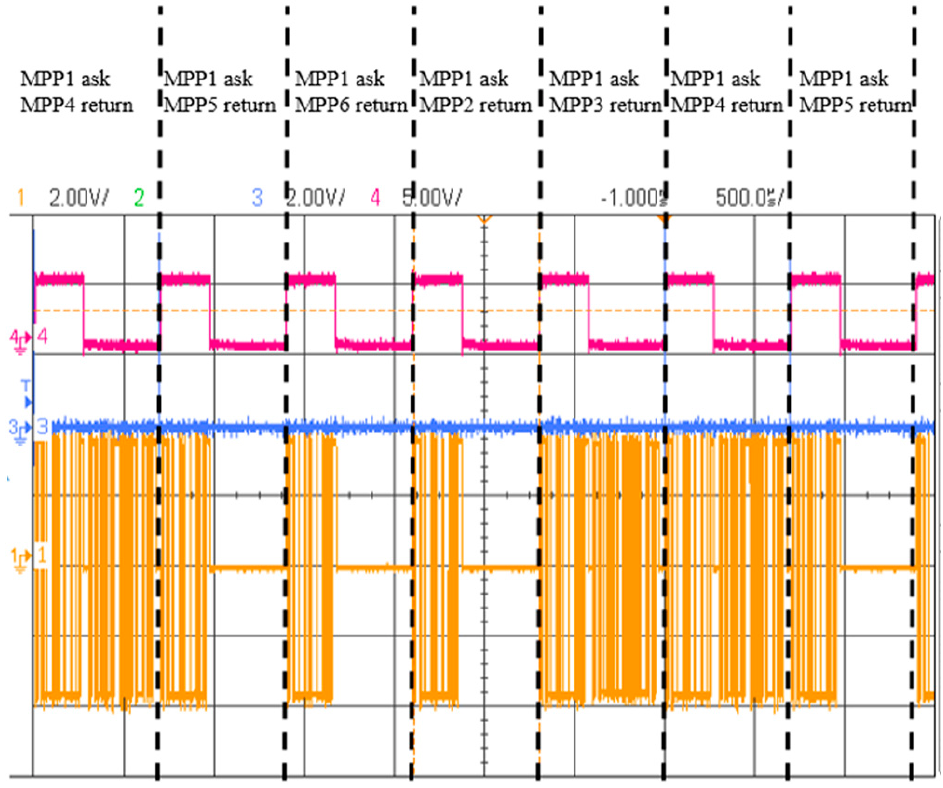
Figure 13. RS-485 communication waveform.